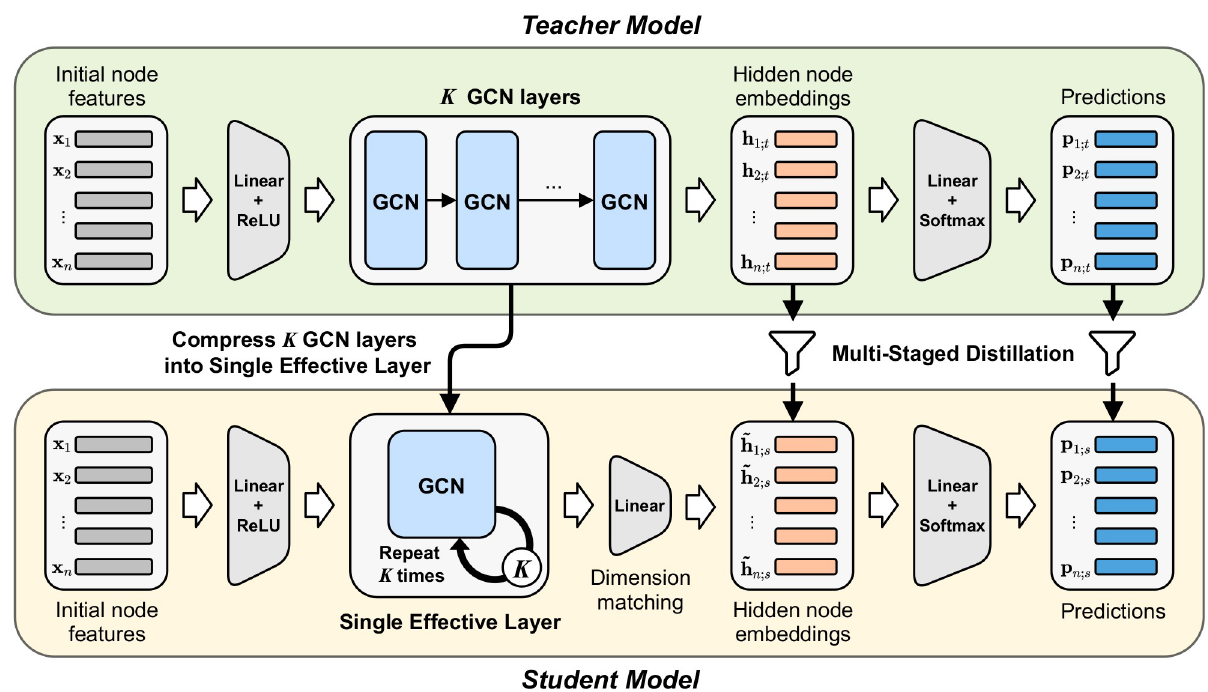
Fig 1. Framework of MustaD. M USTA D preserves the multi-hop feature aggregation of a teacher with a single effective layer in a student. Furthermore, M USTA D distills knowledge of 1) aggregation from multi-staged GCN layers as well as 2) task prediction. h i ; t represents the teacher’s last hidden embedding of node i , and ~ h corresponds to the student’s last hidden embedding of node i where the hidden dimension is matched to the teacher. p i ; t i ; s and ~ p denote the prediction probability vectors of node i of the teacher, and the student, respectively. i ; s